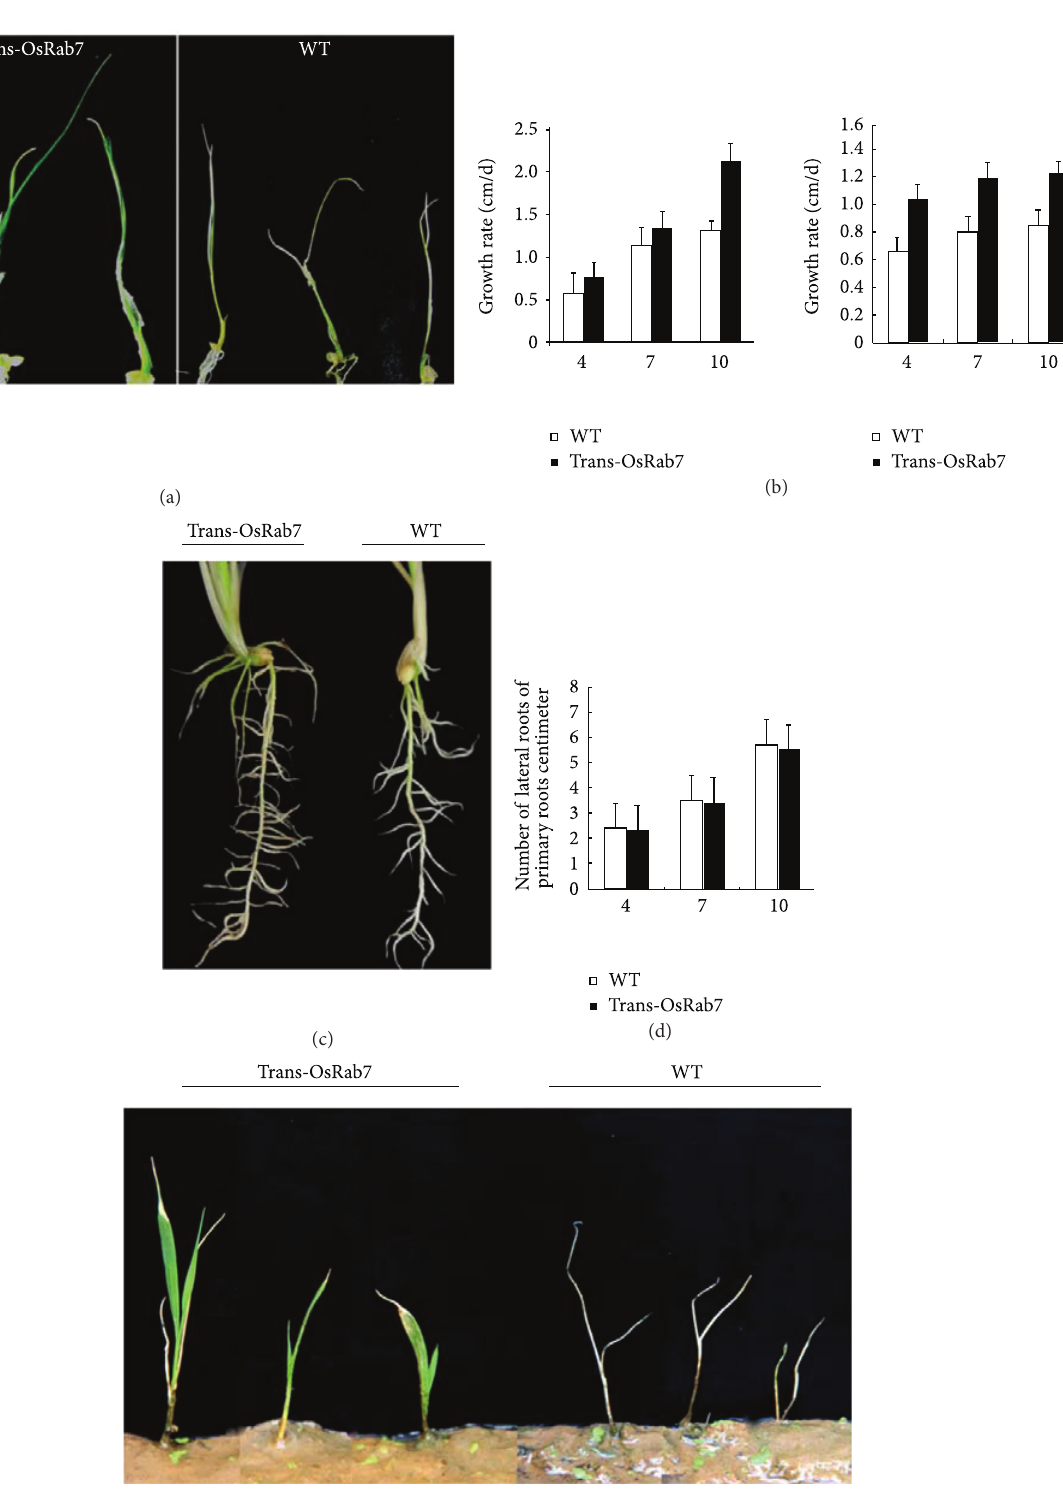
Figure 2: Salt stress tolerance in wild-type and transgenic plants. (a) Morphology of wild-type and transgenic seedlings after 12 days under 200 mM salt stress. (b) Growth rate compared between the transgenic rice and WT plants under salt stress. (c) Root morphology under salt stress. (d) Analysis of the number of lateral roots at 4, 7, and 10 days. The data represents the mean ± SD derived from three separate experiments. The bars represent the average data collected from 10 plants of each of the WT, Trans3, and Trans5 lines. (e) Morphology of wild-type and transgenic seedlings transplanted from salt liquid medium to soil. The wild-type and transgenic seedlings subjected to salt stress for 12 days were transplanted to soil, and the transgenic seedling growth was rescued after 8